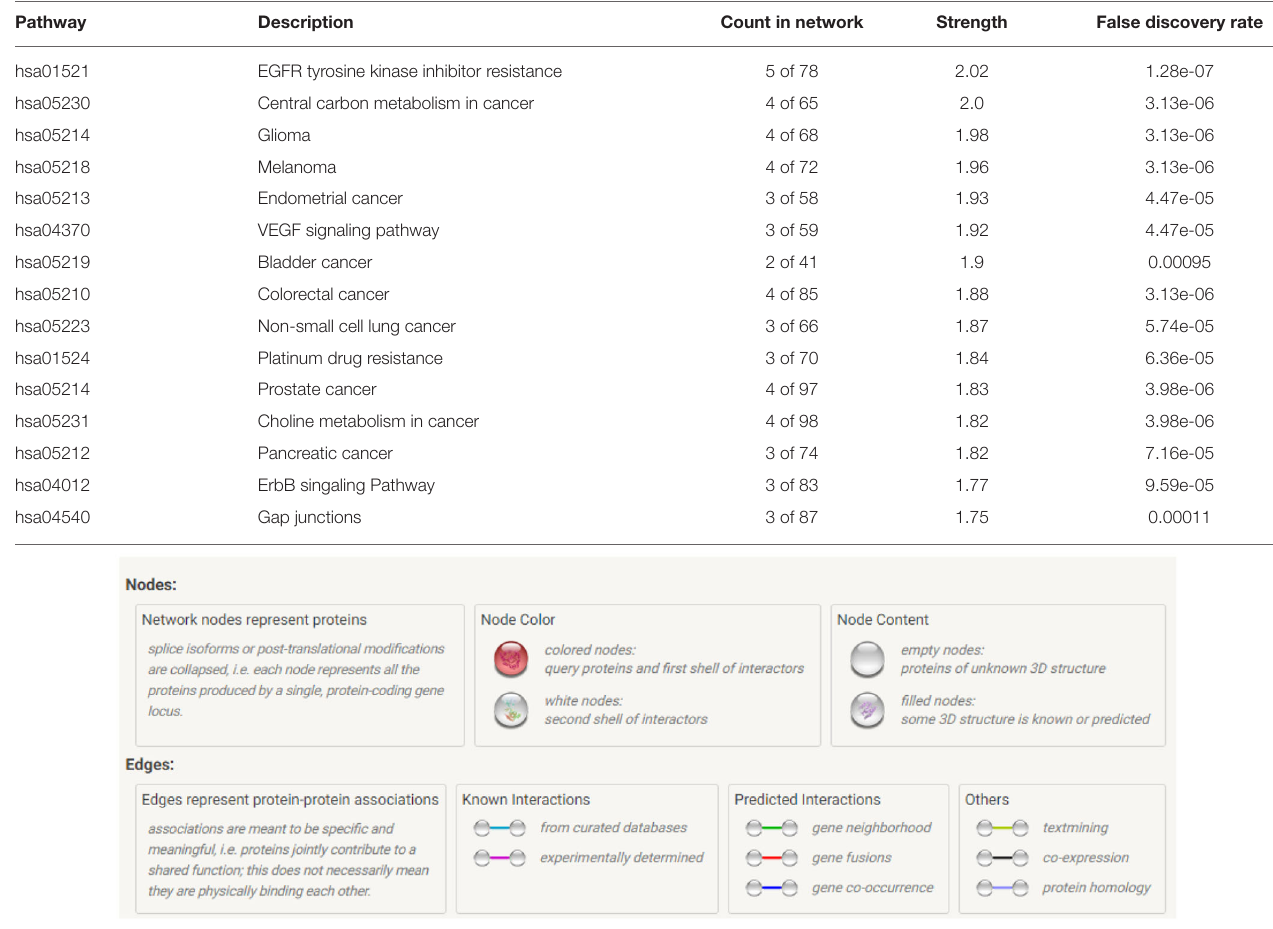
TABLE 1 | KEGG pathway analysis reveals the top tumorigenic pathways in which our proteins are affiliated indicating the count in network, strength, and the false-discovery rate. Pathway